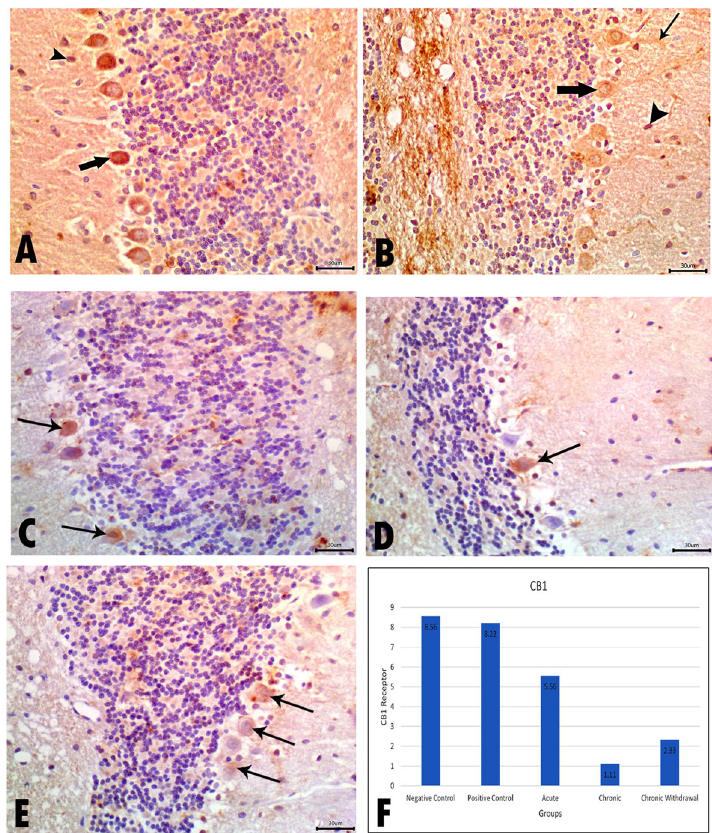
Fig 4 Photomicrographs of sections in the cerebellar cortex immunohistochemically stained with cannabinoid receptor 1 (CB1) ( Negative and positive control groups show strong positive immunoreaction of Purkinje cells (thick arrow) as well as the nuclei of some cells in the molecular layer (arrowhead). The arrow points to the Purkinje dendrites in the molecular layer. C Acute treated group shows a decrease in positive reaction in Purkinje cells (arrows) compared to control groups. D Chronic treated group reveals few positive reactions in Purkinje cells (arrow). E Chronic withdrawal group shows a mild increase in positive reaction in Purkinje cells (arrows) compared to the chronic group. F The bar chart shows the quantitative estimation of the mean count of CB1-positive cells. Data are expressed as the means acute, chronic, and chronic withdrawal